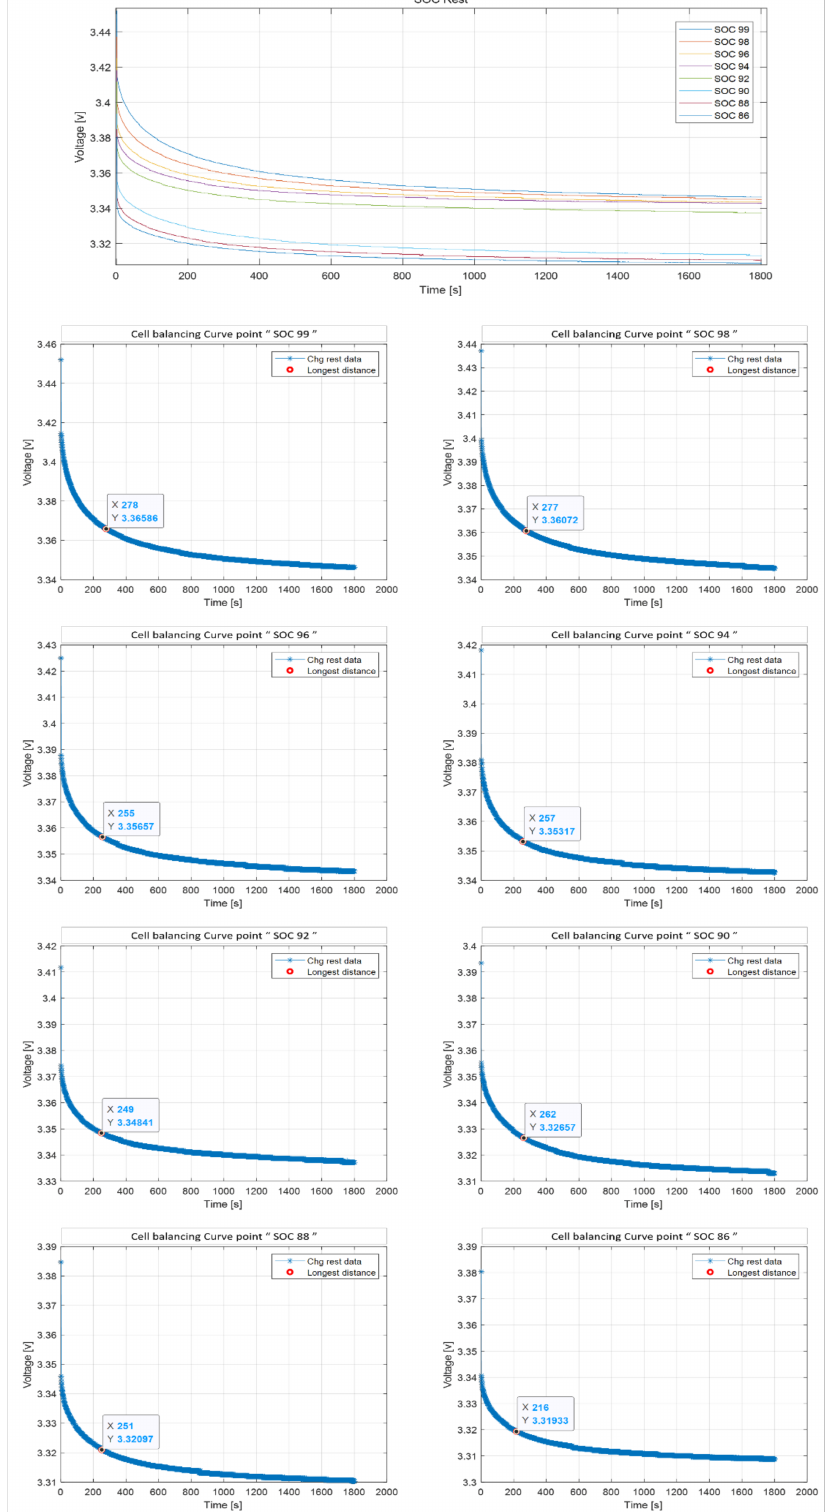
Figure 6. Voltage and curve point during 3 h of rest after fully